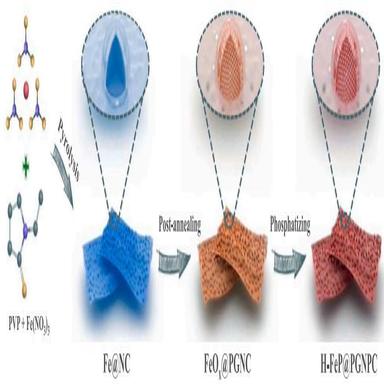
Schematic illustration for the fabrication procedures of the H-FeP@PGNPC.